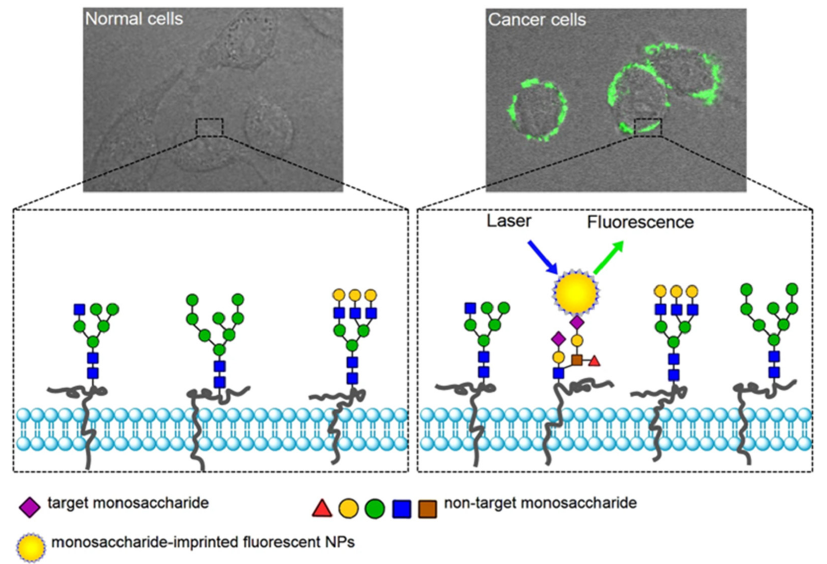
Figure 13. Illustration of the targeting and imaging of cancer cells with MIP@FTC@SiO 2 nanoparticles. Reproduced with permission from [95].